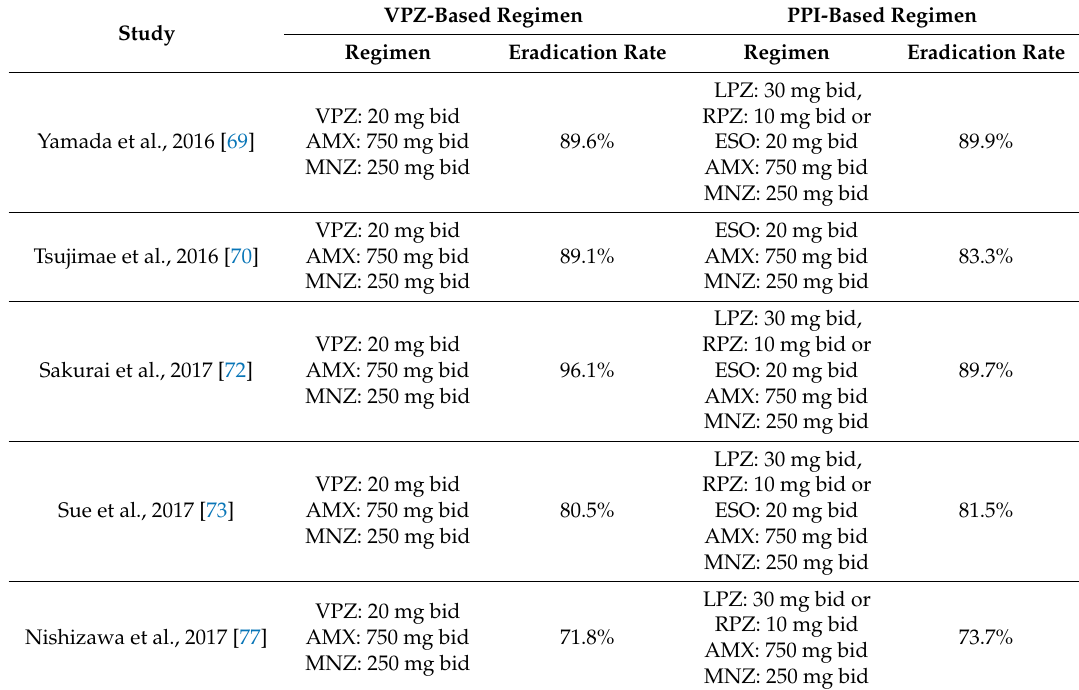
Table 5. Review of comparative studies of second-line H. pylori eradication